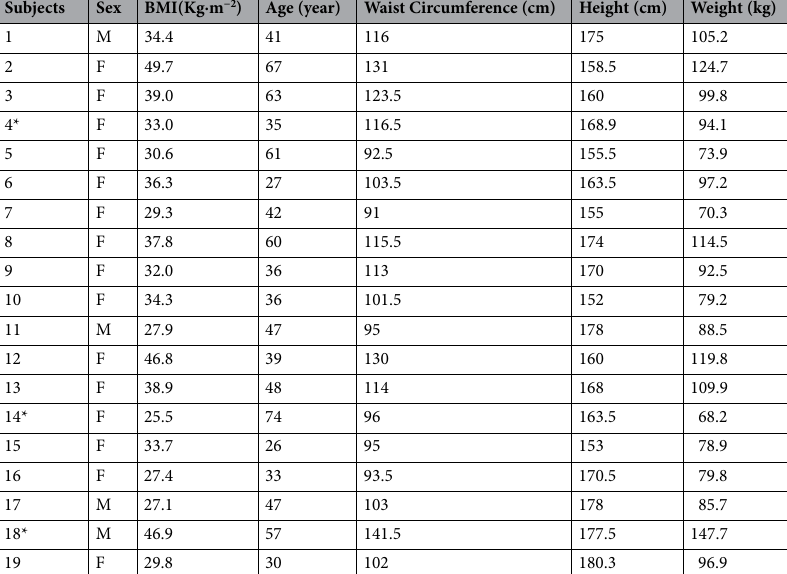
Table 2. Demographics of overweight subjects. The demographics of 19 subjects, including sex, BMI, age, waist circumference, height, and weight, are demonstrated. (Subject 4: electrode malfunction, Subject 14: renal failure, Subject 18: leukemia, *